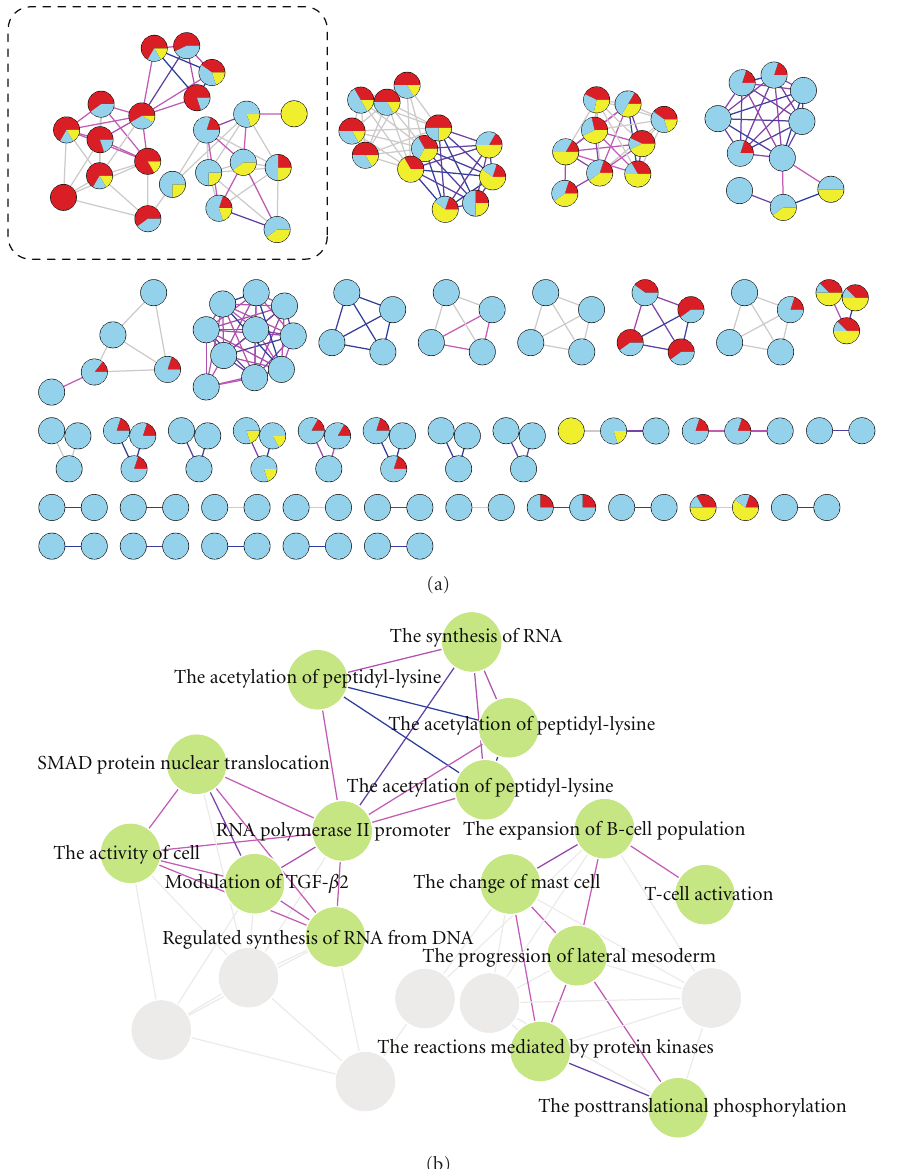
Figure 8: The module-module communication network and functional characterization. The network is built by GenePro 2.5.2b [39]. Each node represents a module, and the edge between two nodes means these two modules share at least one protein. Edge color represents the GO similarity: the values between 0 and 1 are painted with a pink/blue color gradient, and gray means lack of GO annotation. (a) The module module communication network. In the pie plot of each node, the color means function: red is cancer related, yellow is immune related, and blue is other function. The size of sector means the percentage of each type of functional proteins. (b) Functional characterization of each module in the largest cluster (rounded by rectangle of dotted line). Modules are painted green (if there is a GO annotation) or gray (lack of GO